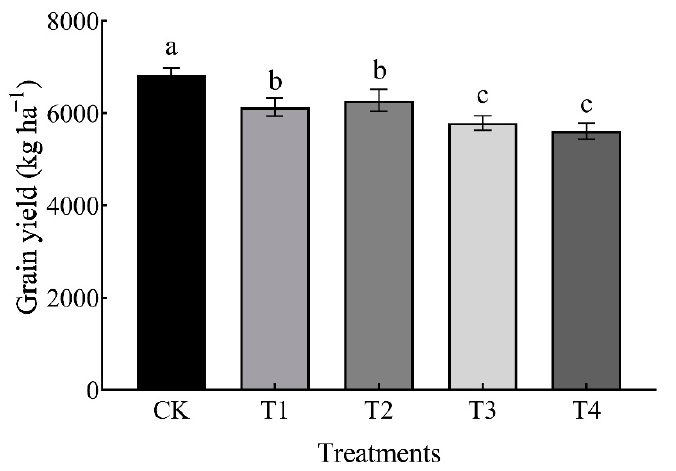
Figure 6. Winter wheat grain yield (kg ha − 1 ) under different irrigation regimes; vertical bars represent standard errors (SE, n = 3). Different lowercase letters show that the mean values are significant based on LSD multiple range tests at p < 0.05.